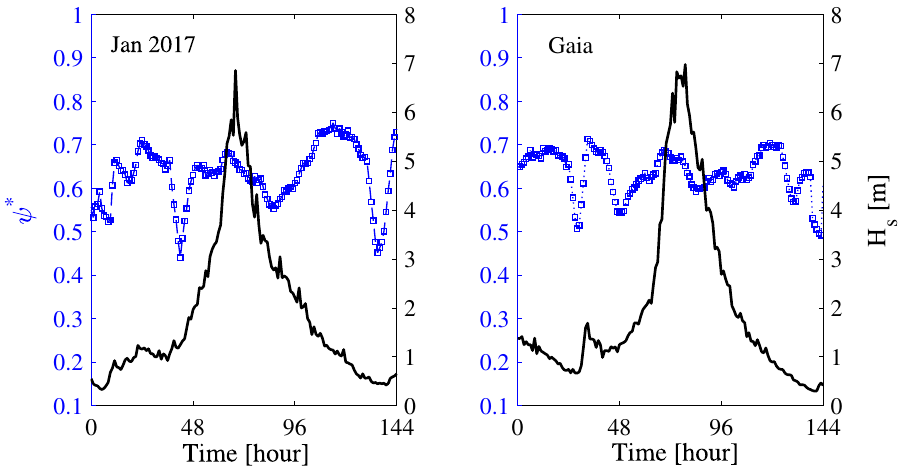
Figure 3. Metocean parameters history during storms Jan 2017 (left panel, start date Jan 25, 2017, 00:00) and Gaia (right panel, start date Jan 16, 2017, 00:00): hourly variation of Boccotti parameter ψ ∗ and the significant 4 σ . wave height estimated as H s =